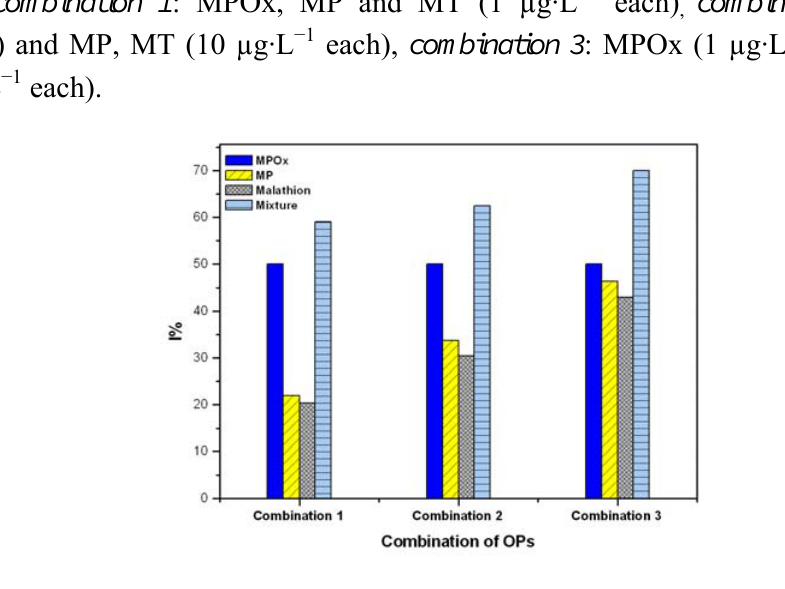
combination 2 : MPOx ,